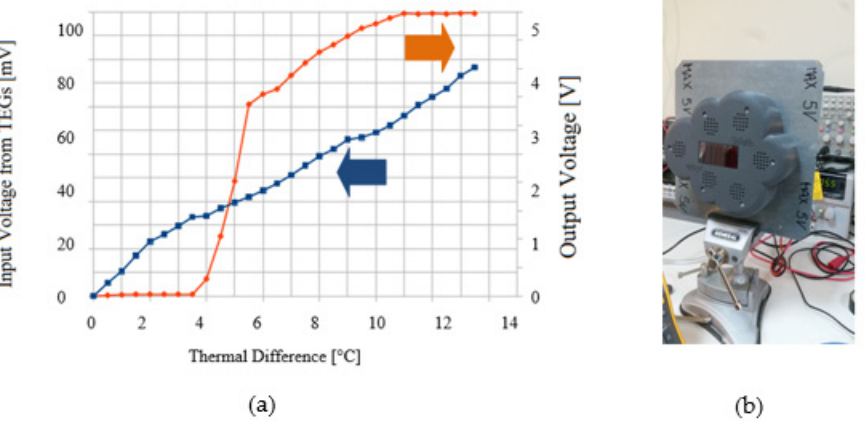
Figure 8. ( a ) SERENO prototype installed on a metallic plate driven by externally driven Peltier cells to impose thermal gradients; ( b ) behavior of TEG output with thermal gradients from 4 to 12